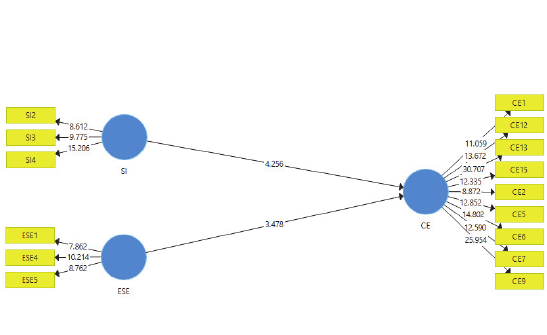
Fig. 2 . Structural model